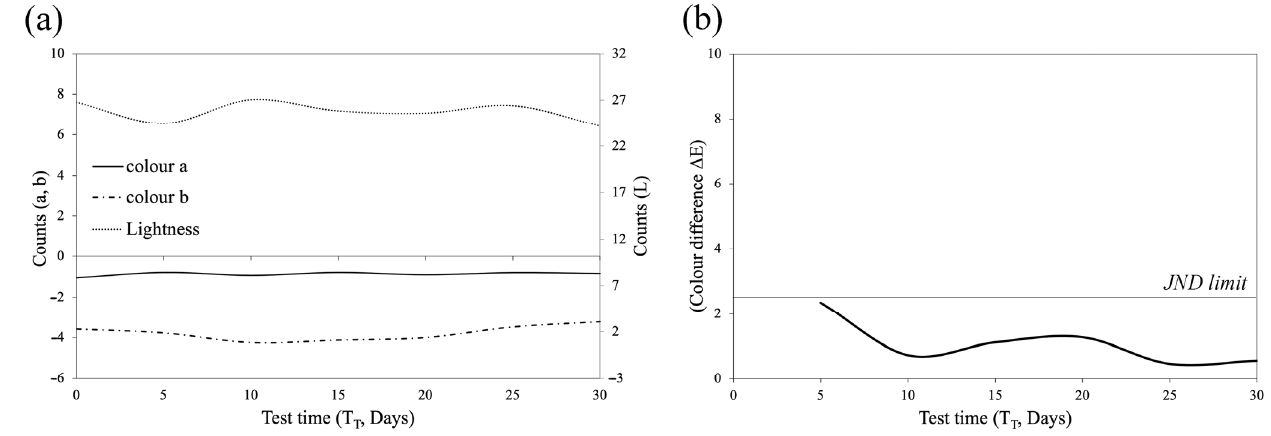
Figure 7. ( a ) Trends of CIEL*a*b* color parameters during 30 days of solar exposure test; ( b ) color difference according to the JND limit (just noticeable difference = 2.37).